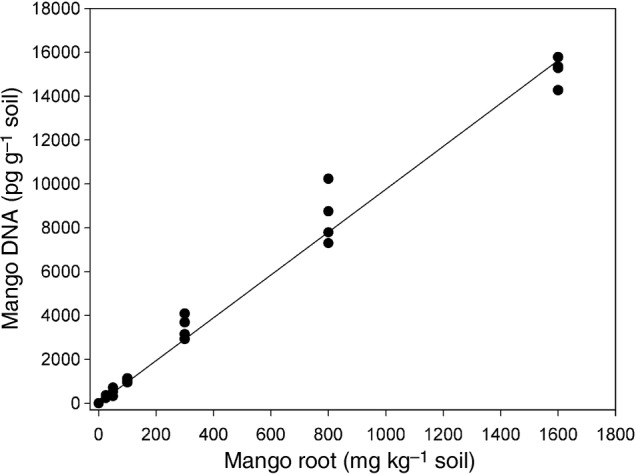
Root dry matter concentrations (0, 25, 50, 100, 300, 800 and 1600 mg kg−1) of KP root tissue in control soil plotted against pg DNA (g soil)−1 values (Exp. 4), with a fitted linear regression, y = 9.7666 (x), P < 0.001, adjusted multiple R2 = 0.9909, standard error of coefficient 0.1769, df = 27 (Exp. 4).